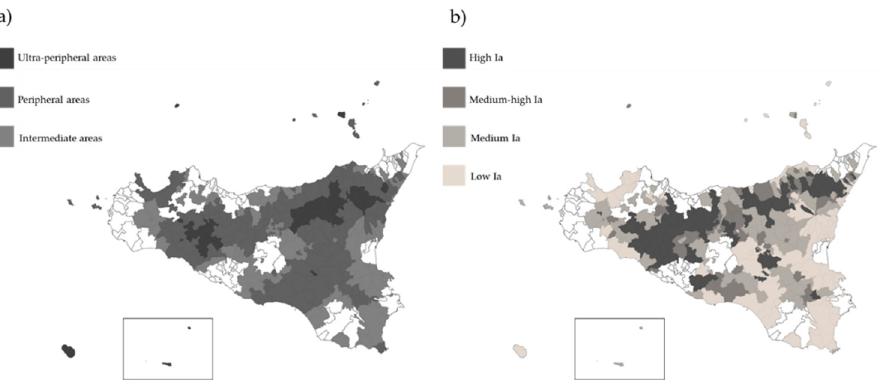
Figure 18. Comparison between the NSIA classification of inland areas and that based on the abandonment index I a . ( a ) highlights the map of interen areas based on the classification of the NSIA; ( b ) highlights the map constructed based on the abandonment index . (Authors’ elaboration.)